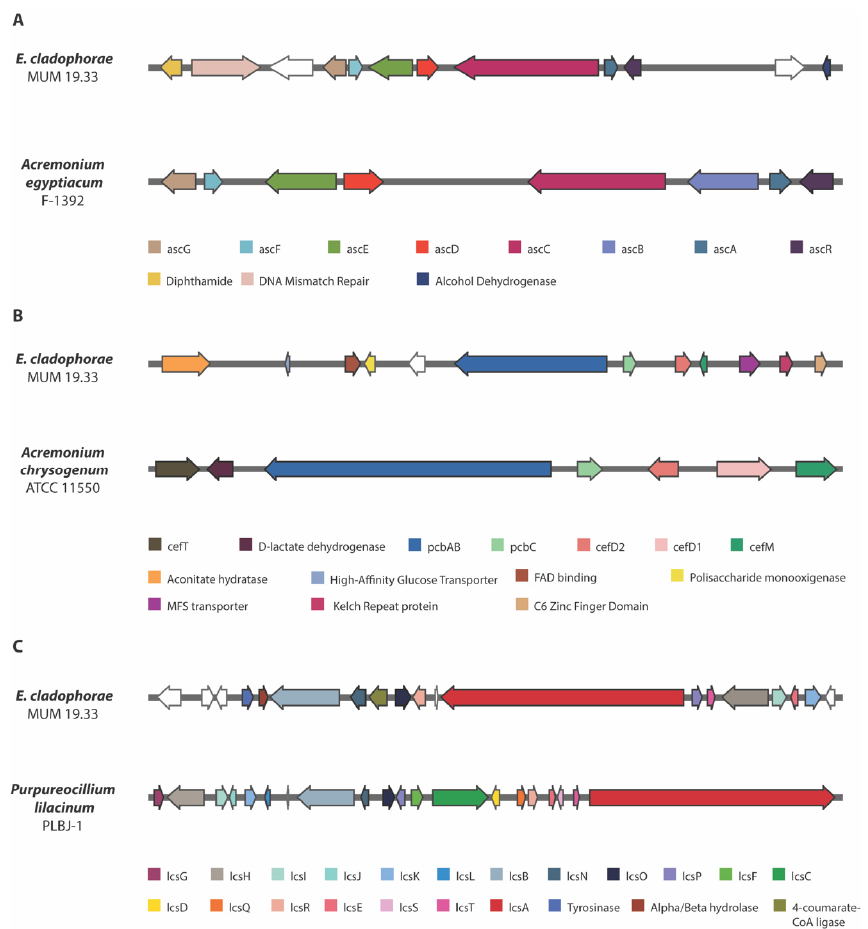
Figure 2. Comparison of three biosynthetic gene regions in Emericellopsis cladophorae MUM 19.33 with ( A ) Ascochlorin BGC of Acremonium egyptiacum F-1392; ( B ) Cephalosporin C BGC of Acremonium chrysogenum ATCC 11,550; and ( C ) Leucinostatin A/B BGC of Purpureocillium lilacinum PLBJ-1. The genes that encode hypothetical proteins are represented as white arrows.